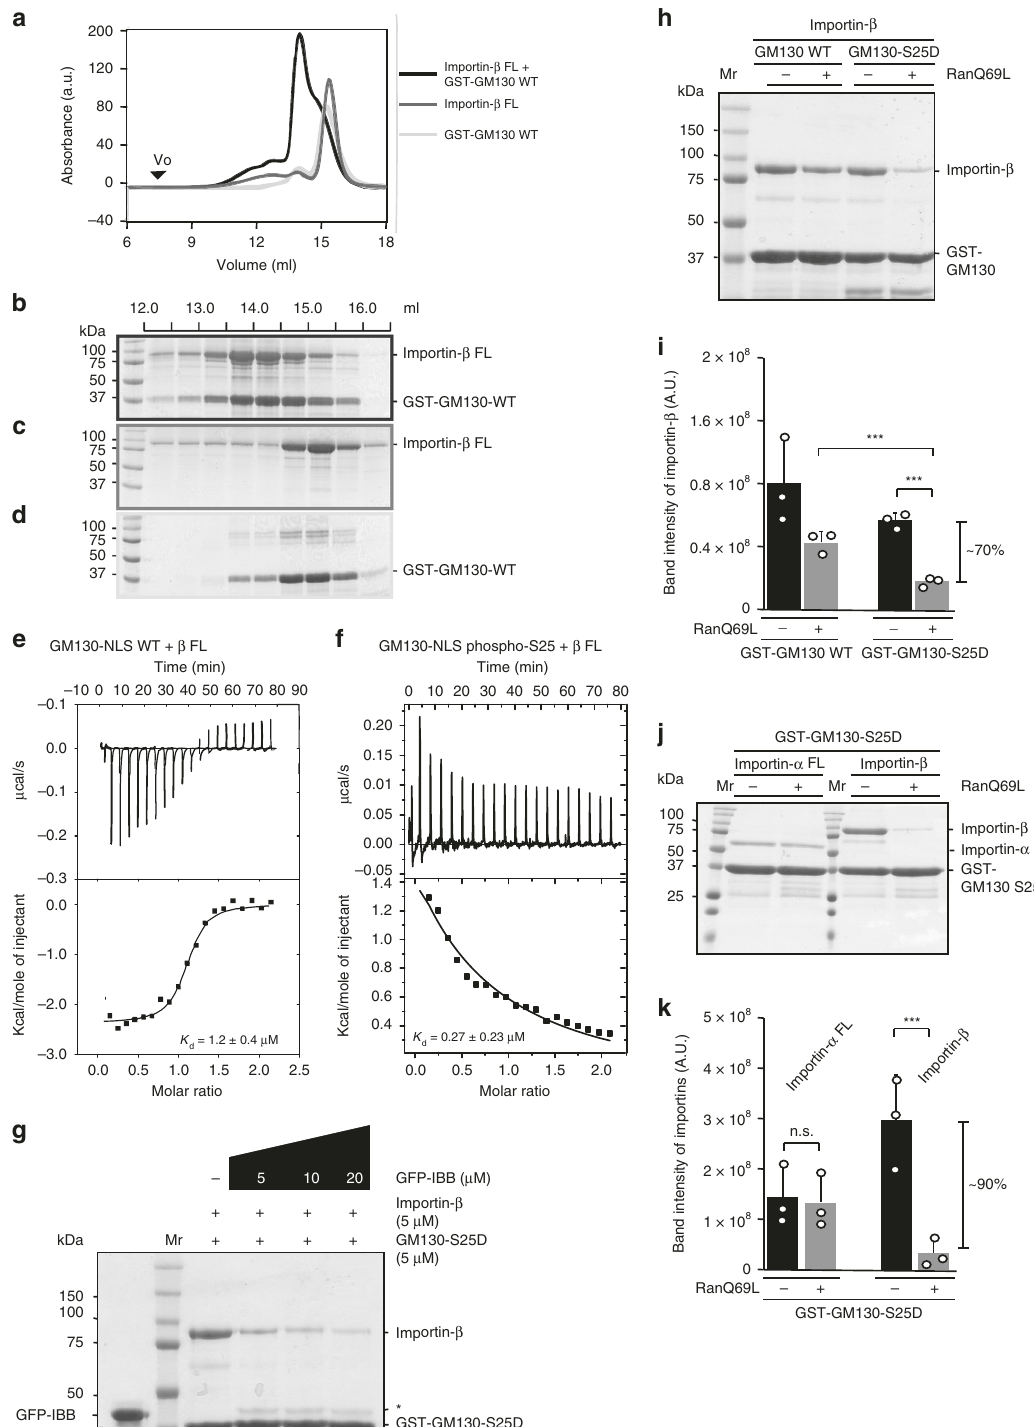
mutant metaphase cells stained by GRASP65, and Giantin and GM130 interaction is comparable for the wild-type and antibodies displayed comparably elevated fl uorescence intensities mutant protein (Fig. 6g, interphase cells). Only a few fl uorescent and punctate fl uorescence patterns (Fig. 6b, c, e, f). We then dots could be observed in the wild-type mitotic cells (Fig. 6g, h), arrested cells in prometaphase using nocodazole and examined indicative of reduced vesicle – Golgi fusion. However, mitotic p115 and GM130 protein – protein interactions using antibody- K34A mutant cells exhibited higher numbers of fl uorescent dots based PLA. During interphase, we observed punctate fl uorescence compared to wild-type (Fig. 6g, mitotic cells), as evidenced by concentrated near the nuclei of both wild-type and mutant cell quantitative analysis (Fig. 6h). These results suggest that the p115 lines, indicating that the vesicle – Golgi fusion facilitated by p115 and GM130 interaction is enhanced in the K34A mutant cell line NATURE COMMUNICATIONS| (2019) 10:4307